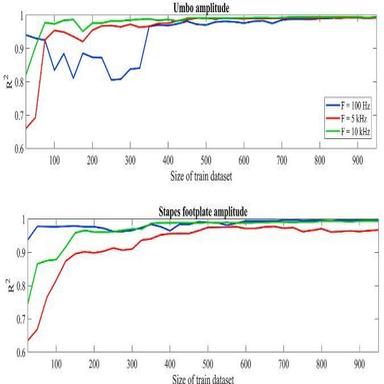
The values of R2 with respect to the size of the training dataset at three different frequencies: 100 Hz (low), 5 kHz (middle), and 10 kHz (high). For both amplitudes of the umbo and stapes footplate, an R2 of about or greater than 0.95 is attainable when we have more than 400 model simulations in our testing dataset.